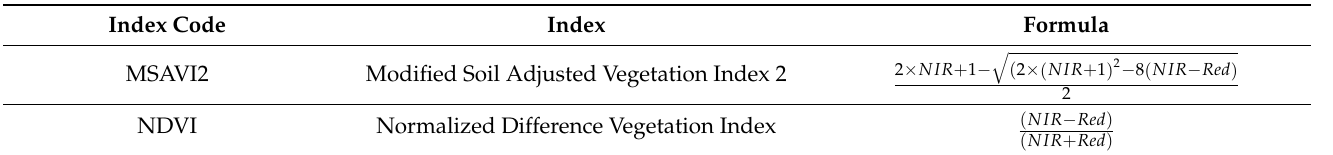
Table 3. Vegetation indices used in the analysis